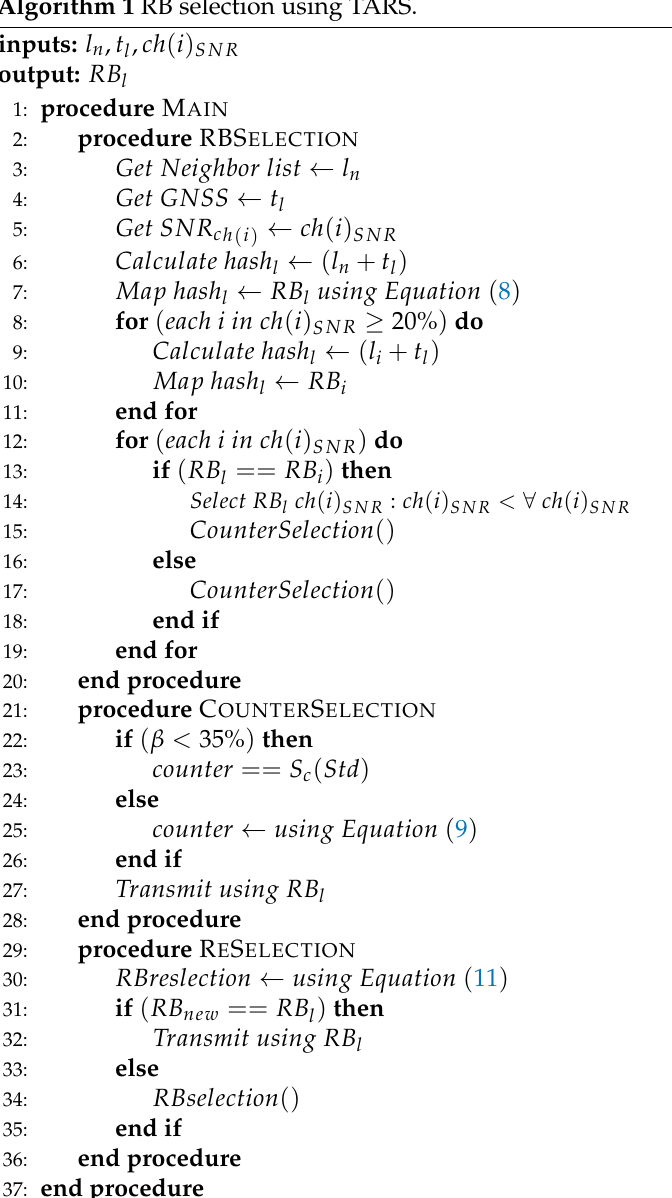
Algorithm 1 RB selection using